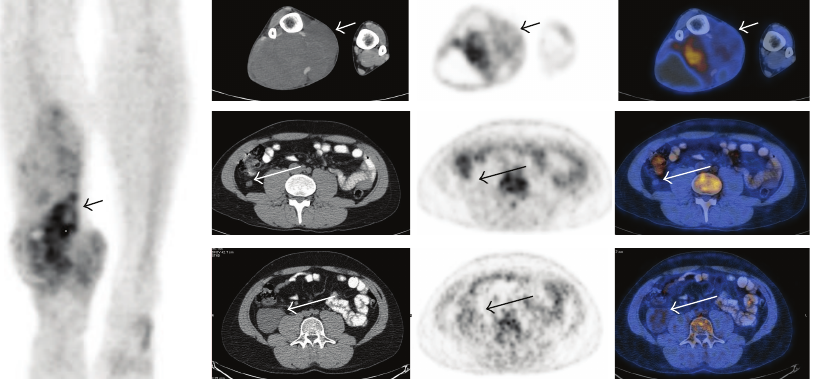
Figure 4: True positive in this 58-year-old patient with malignant peripheral nerve sheath tumor of the right thigh (long arrow). The FDG- PET scan demonstrated two additional hypermetabolic lesions in the left calf (short arrow). These were subsequently resected and proven to be synchronous peripheral nerve sheath tumors. Four years later, the patient is in remission and is doing well.